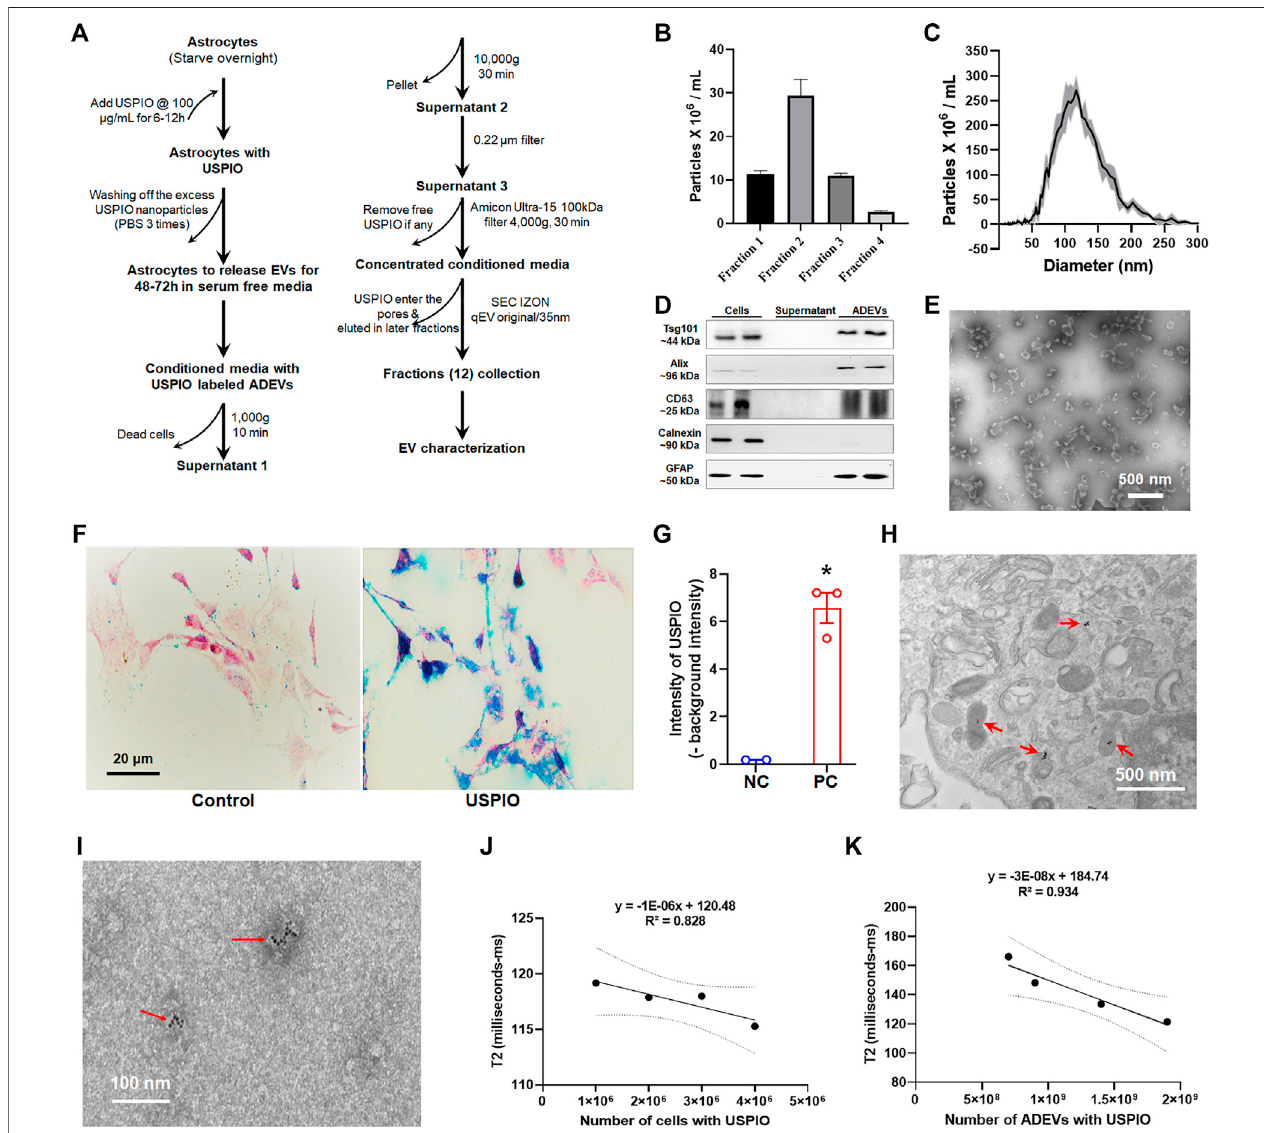
FIGURE 1 | Uptake of USPIO by mouse astrocytes and characterization of EVs. (A) Schematic diagram of the procedure used for separating EVs from astrocyte culture by size exclusion chromatography (SEC). (B,C) Number and size distribution plots of EVs from selected fractions by ZetaView. (D) The four fractions of the qEV column with maximum EVs were pooled together for detection of EV markers using Western blotting. EV proteins were separated by sodium dodecyl sulfate – polyacrylamide gel electrophoresis (SDS-PAGE) and electroblotted onto a nitrocellulose membrane. Calnexin (non-exosomal protein) served as negative control. (E) TEM image of EVs isolated from mouse astrocytes via a qEV column (IZON Science). (F) Cells were treated with 100 μ g/ml of USPIO, and uptake of USPIO nanoparticles was determined by nanoparticle uptake assay. (G) Blue signal intensity in (F) measured using ZEN (Blue edition) software. (H) TEM image of astrocytes treated with USPIO. (I) TEM image of EVs isolated from USPIO-treated astrocytes. (J,K) Decrease in T2-weighted data acquired using MRI showing a strong linear correlation between R2 values and numbers of cells (R2 = 0.828), and numbers of ADEVs (R2 = 0.934). All experiments were repeated at least three